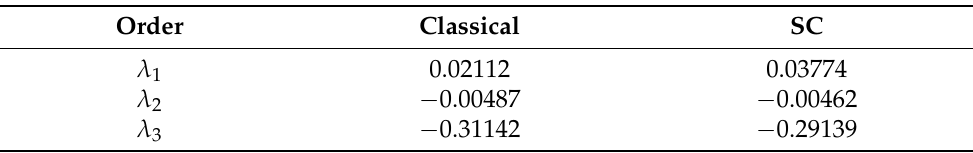
Table 1. Values of the first three Lyapunov exponents for the “Z” variable in the cases of classical integration and SC